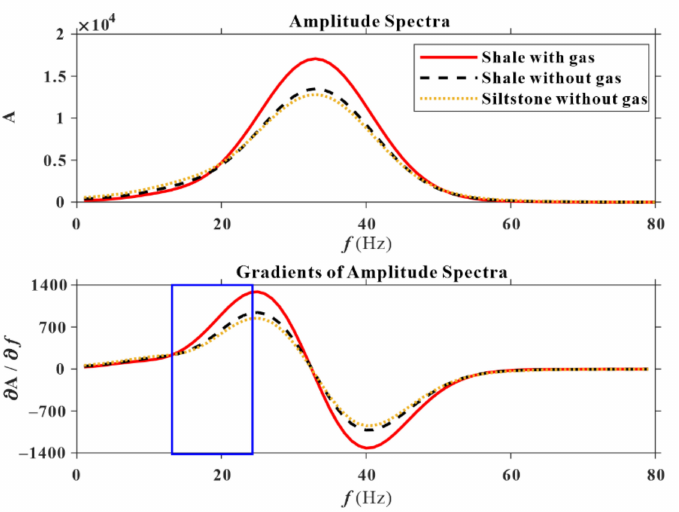
Figure 6. Seismic amplitude spectra ( top ) and the corresponding frequency gradients ( bottom ) for different lithologies with different gas-bearing conditions near well S-2 versus